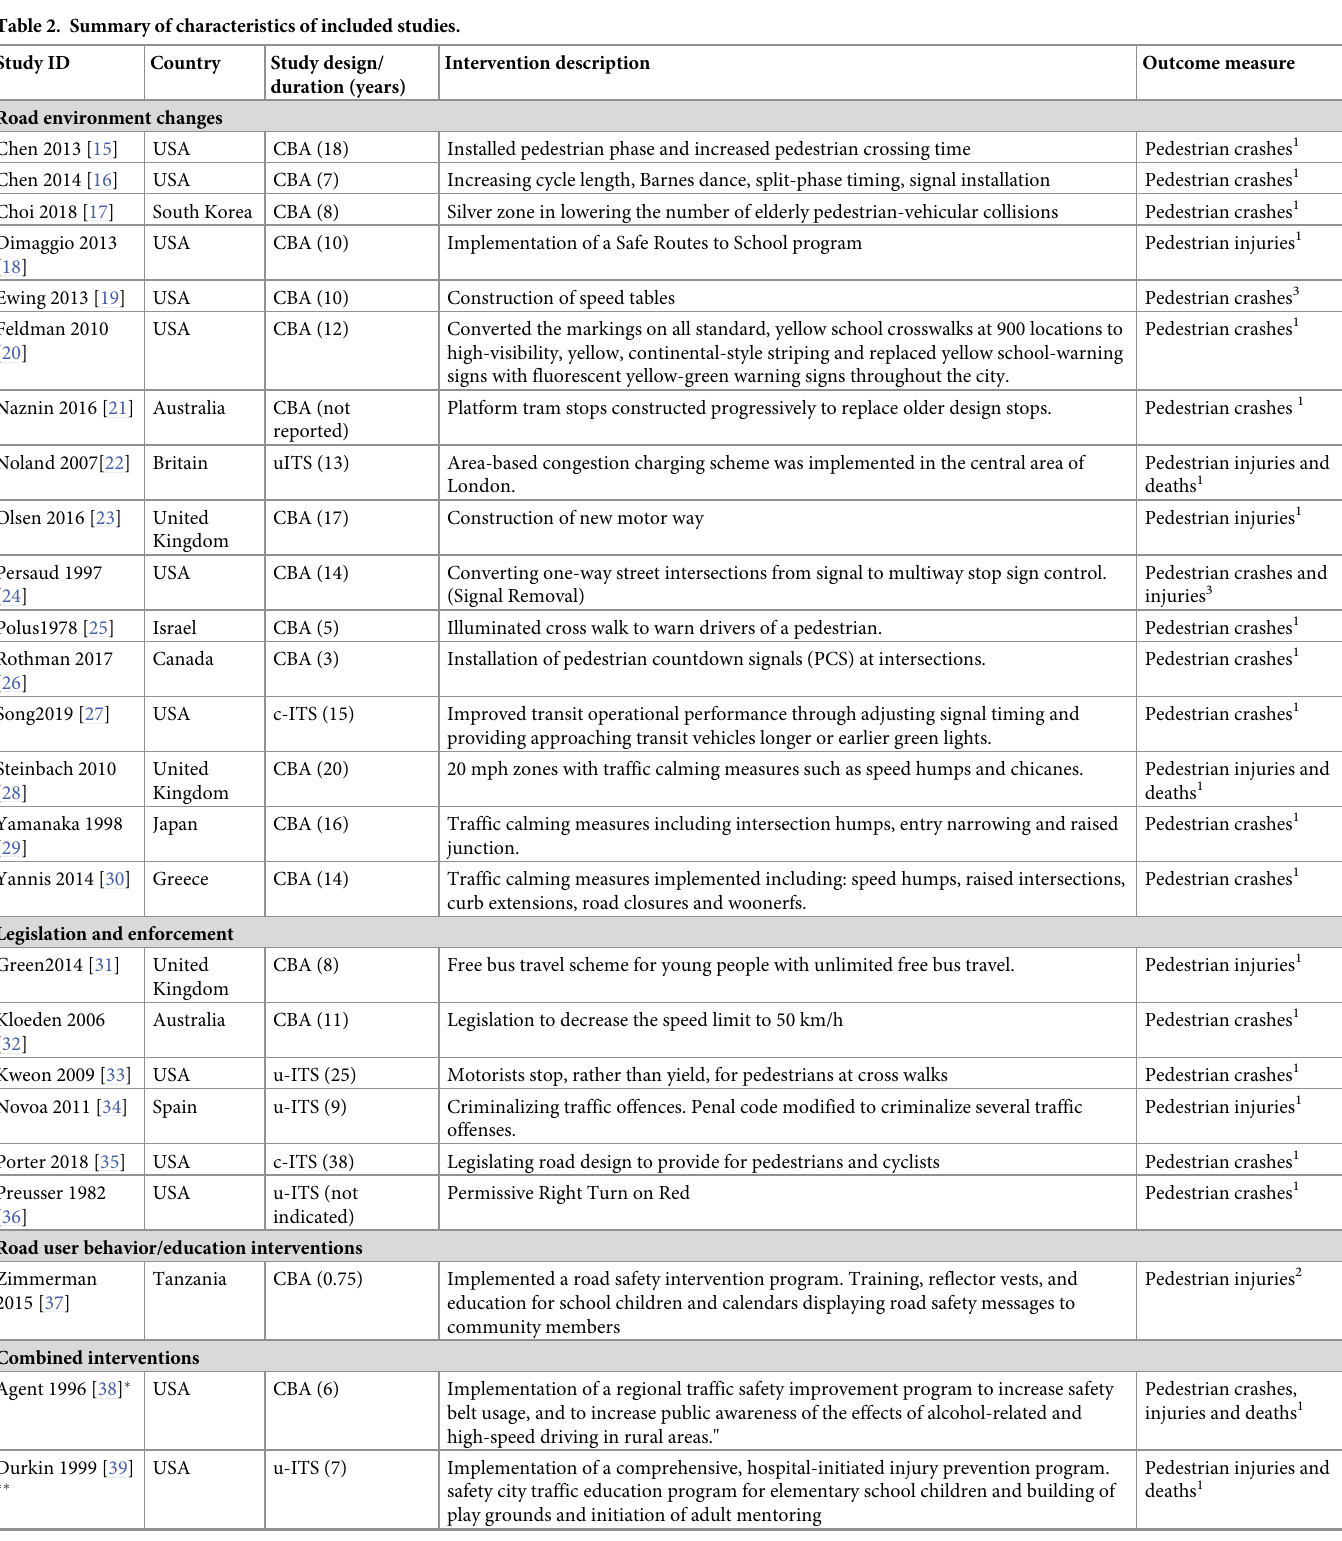
Table 2. Summary of characteristics of included